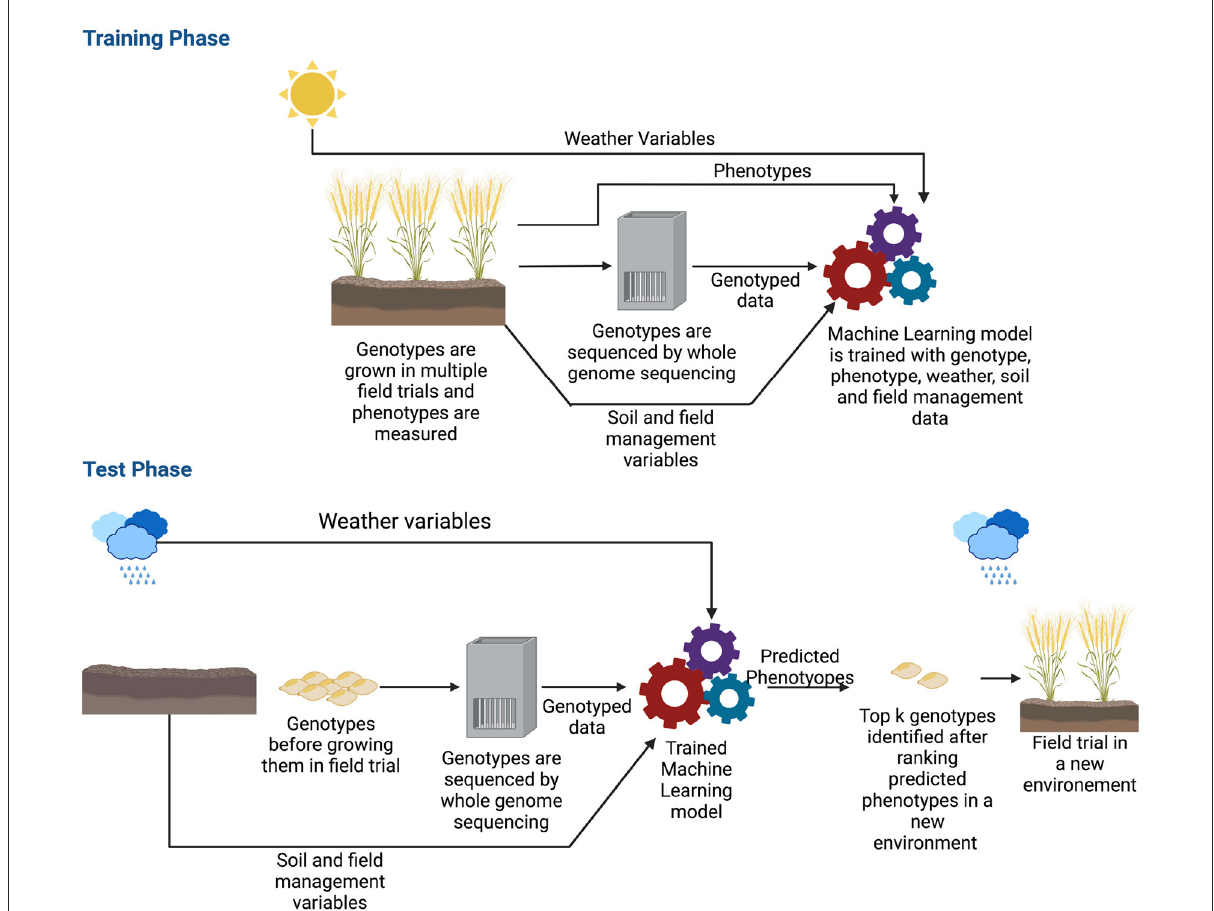
FIGURE6 Workflow of genomic selection in a multi-environment trial. Before training the machine learning model, along with genotyped and phenotyped data, environmental information such as weather variables, soil and field management data are also collected. The genotypes are typically grown in multiple seasons/locations which provides a wide range of environmental data. During the training phase, the model is trained with all these data along with phenotypes. After the model is trained, in production, the model is given the genotyped data of crops along with environmental information of where the crops will be grown as the input. The model estimates the phenotype for that environment. Based on the estimated phenotypes, the top k genotypes are chosen and grown in the